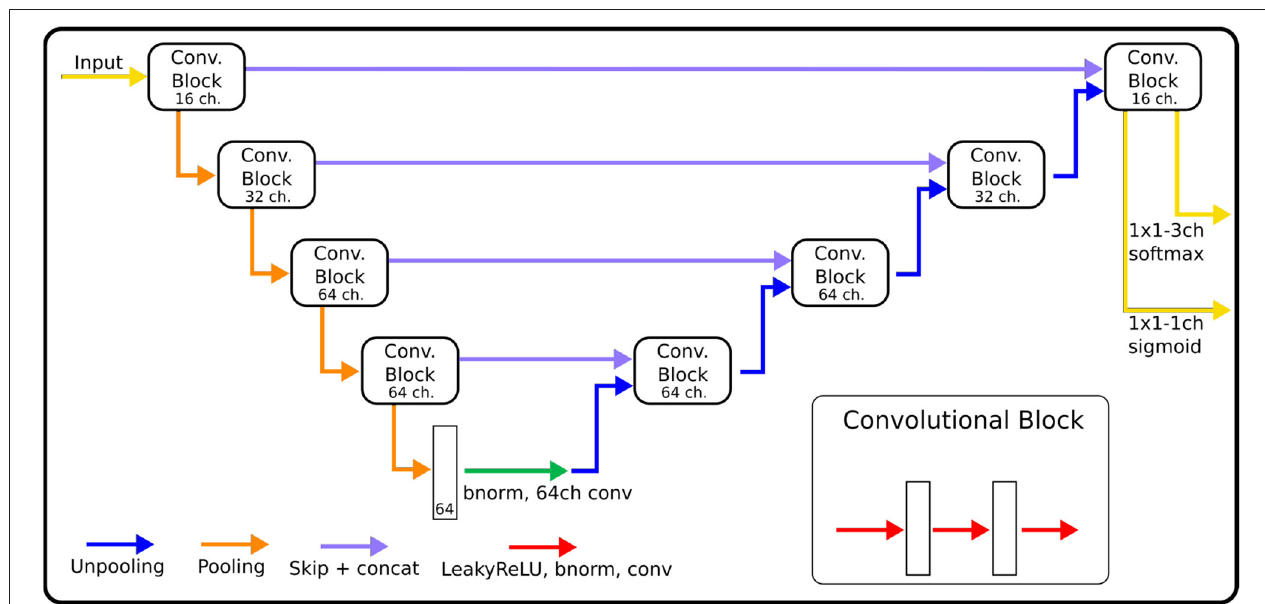
FIGURE 1 | The architecture of CNNs, indicating for each block the number of channels used in each convolution. The size of convolution kernels is 3 × 3 × 3 for the EpiBioS4Rx data, and 3 × 3 for the EPITARGET data.